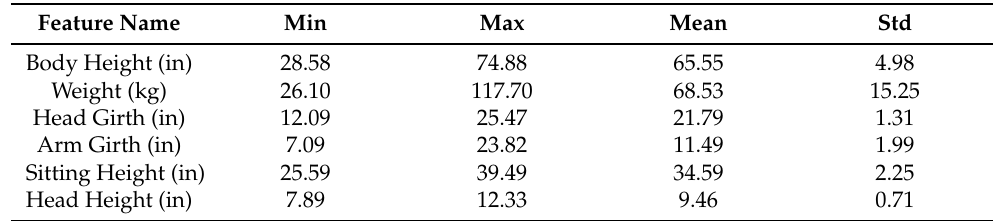
Table 1. Statistics of representative body